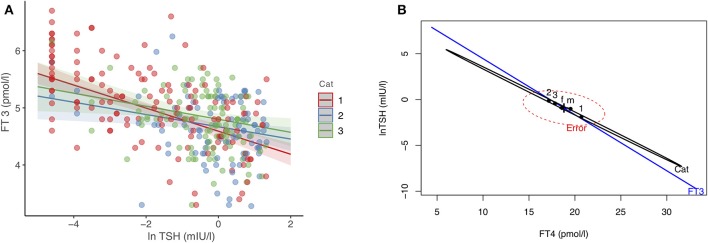
(A,B) Effect plots of the complex interdependency between FT3, FT4, and TSH. (A) shows the relationship between FT3 and TSH, examined by treatment category, after adjusting for FT4 concentrations, gender, age, and BMI. (B) The resulting equilibria between FT4 and TSH (as surrogate markers for setpoints), associated with treatment category and FT3 concentrations in a significant interaction (Pillai-test p < 0.001, see Results for details). The three treatment categories refer to patients with thyroid carcinoma (1), autoimmune thyroiditis (2), and benign goiter (3). f indicates female, and m male gender. Cat, disease category. Regression lines are surrounded by the 95% confidence limit.